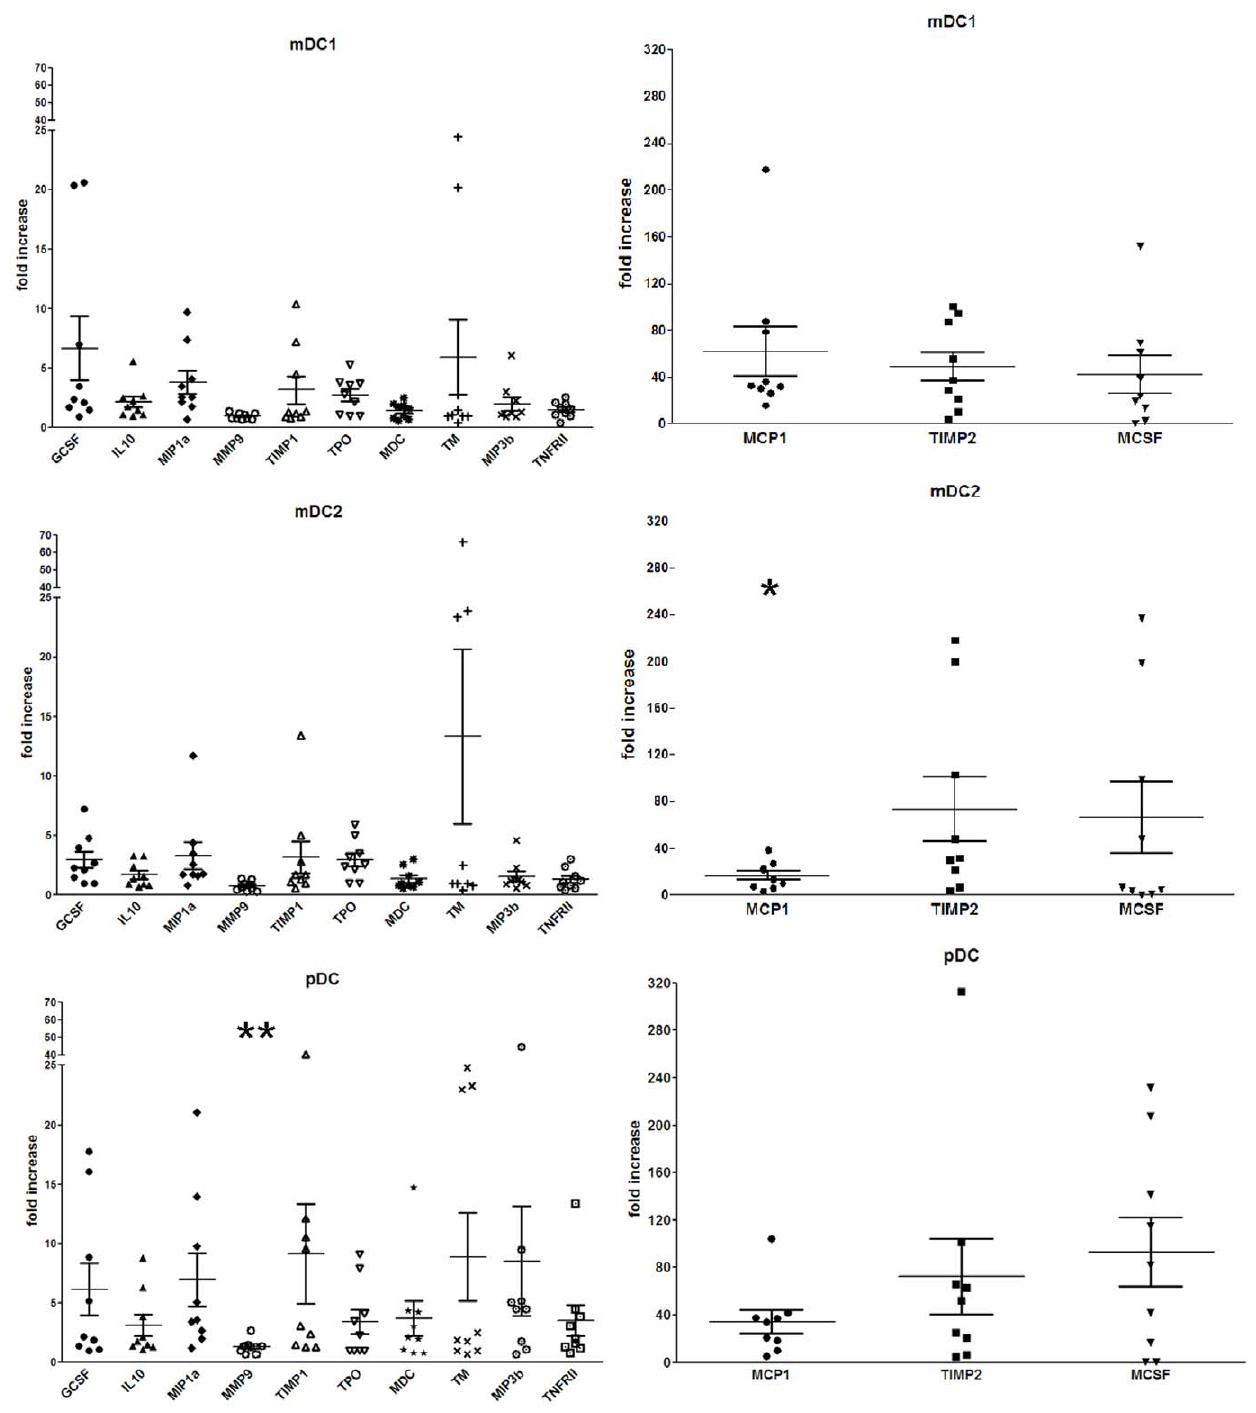
Figure 6. RSV-induced of cytokine, chemokine, and growth factor production measured by multiplex analyses. Cytokine and chemokine levels were measured by multiplex assay. Data represent production levels of RSV-exposed DCs normalized to uninfected DCs of the same cell type. Actual (non-normalized) cytokine concentrations for each donor are detailed in Table S3. N=9 unique donors. * = significantly different from mDC1 only; ** = significantly different from mDC1 and mDC2, p , 0.05. doi:10.1371/journal.pone.0016458.g006 MMP9, TIMP-1, and TPO associated with MIP-1 a production mDC1, inverse correlations were found between TM and MIP-1 a and M-CSF with IL-6, G-CSF, and MMP9, although the negative and MIP-1 b . MMP9 production was found in strong positive correlations were weak (0.01 , p , 0.05). This report is the first correlation to production of IL-6, IL-8, G-CSF, TIMP-1, TPO, examination of MMP9, TIMP-1, and TIMP-2 production in and MDC in mDC2 (red framed values). In pDCs only were